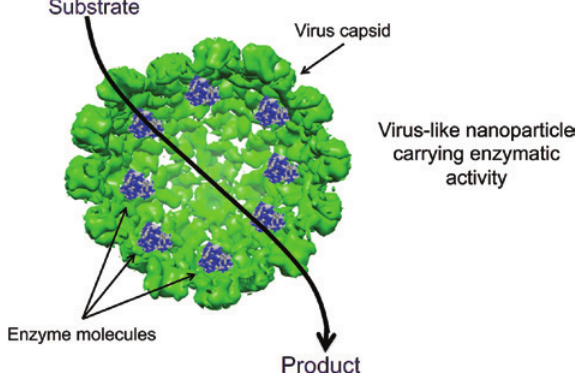
Figure 2: Virus-like particles (VLPs) as nano-vehicles for enzyme delivery. The enzyme molecules are encapsulated inside the virus capsid. The capsid is porous allowing the substrate internalization, and the product can diffuse outside the